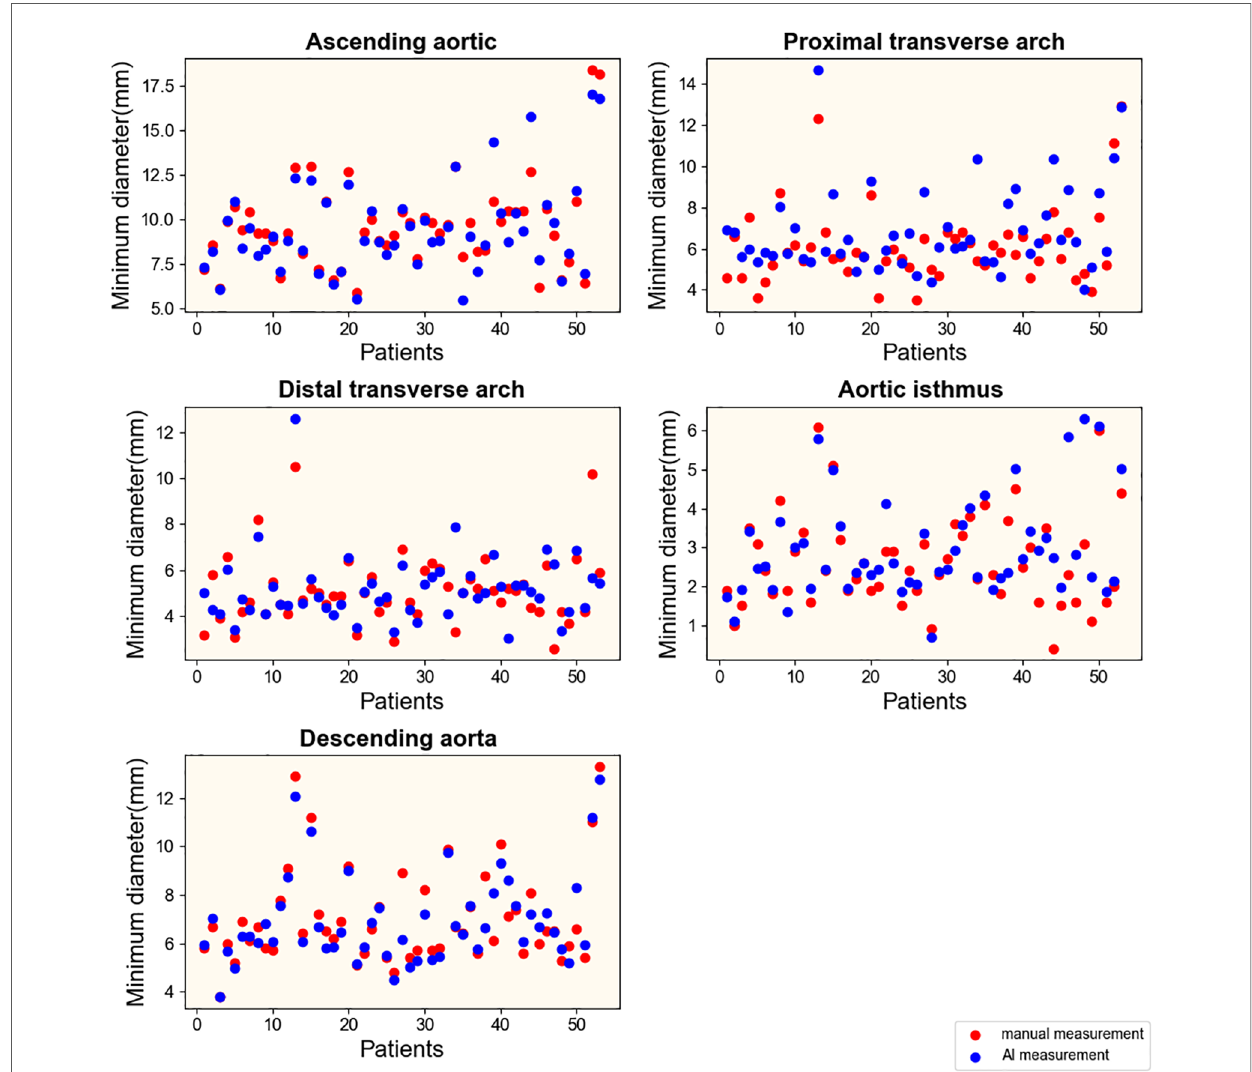
FIGURE 6 Results of measurements in patients with CoA. Manual and intelligent measurements were used to measure the minimum aortic diameter of 53 patients with